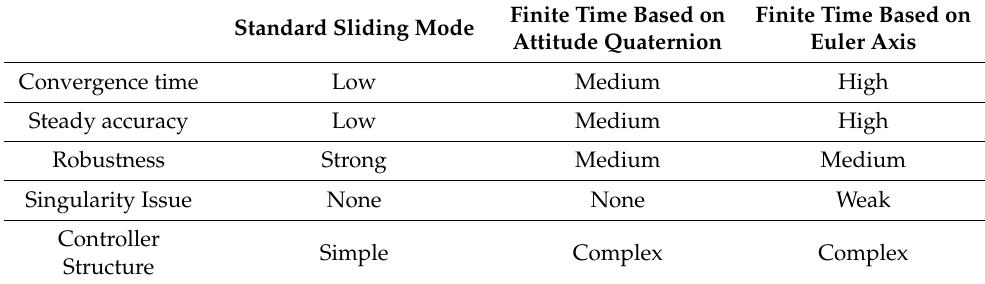
Table 1. Simulation results comparison.